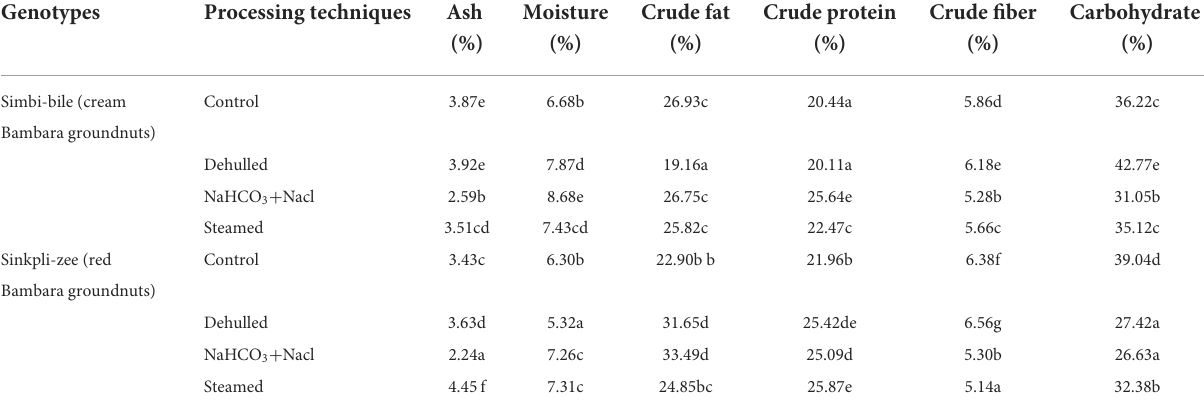
TABLE 1 Effect of processing techniques on the proximate components of Bambara groundnuts.